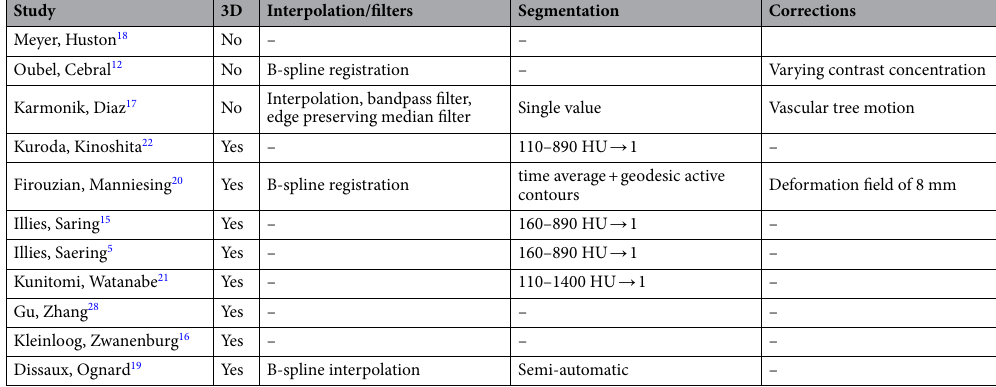
Table 2. Overview of quality of scan, post-processing methods and main outcome. ‘– ’ : no information was mentioned in the original article. Of Illies 15 only the AIDR results are shown, of Illies 5 only the semi-automatic, of Kunitomi the results from the APMC and of Firouzian only the CE-TFEi